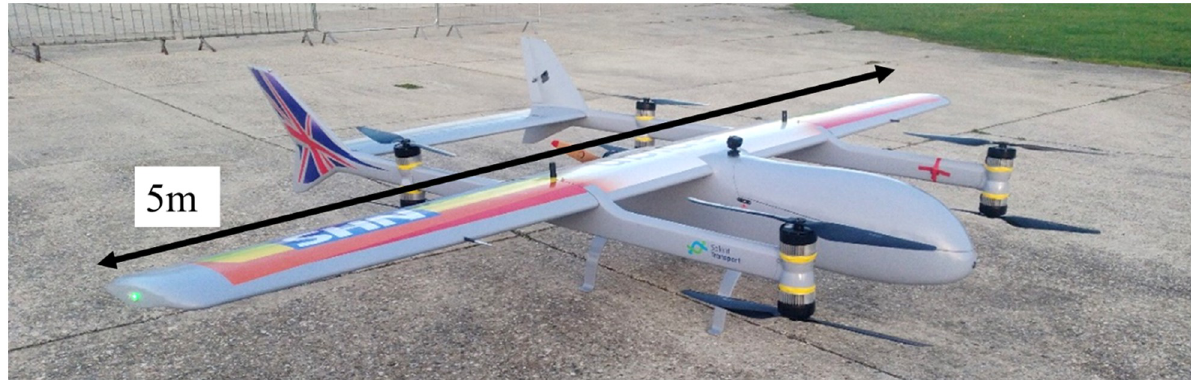
Fig 5. Skylift V50 (Mugin 5 Pro) VTOL drone used in both